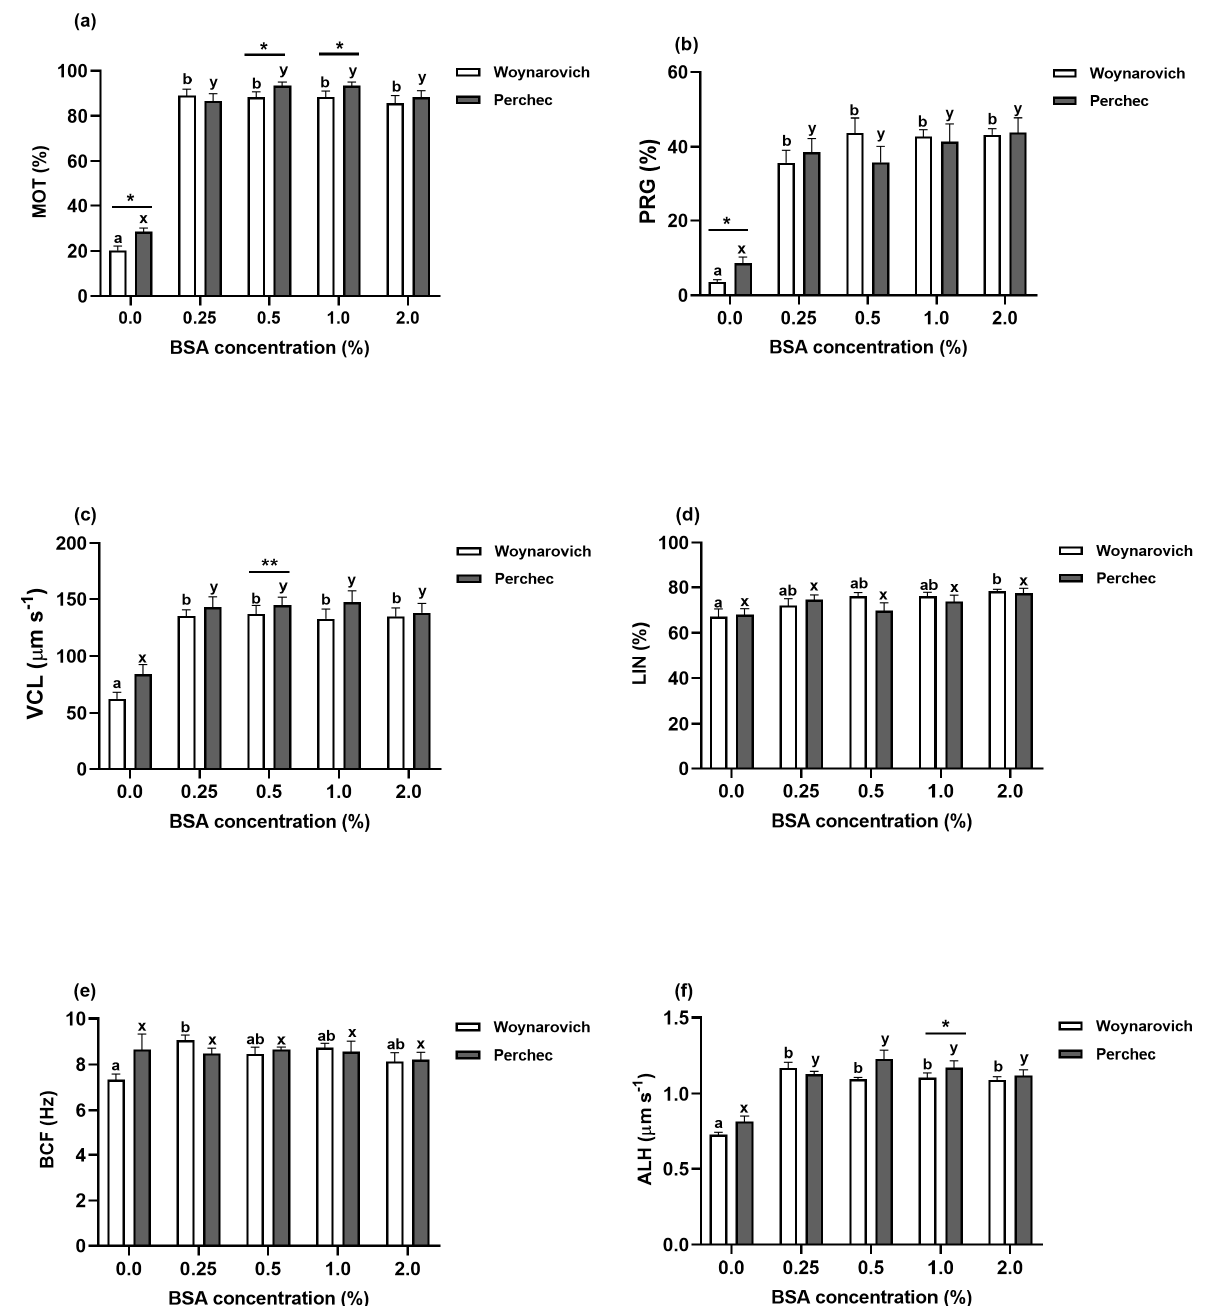
Figure 2. Percentages of motile sperm ( a ), progressively motile sperm ( b ), the curvilinear velocity of sperm ( c ), movement linearity ( d ), beat cross frequency ( e ), and amplitude of lateral head displacement ( f ) after activating ide ( Leuciscus idus , n = 5) sperm motility with Woynarovich and Perchec solutions containing different BSA concentrations. Results presented as mean ± SEM ( p < 0.05). Boxes marked with different letters ( a , b ) indicate significant differences among Woynarovich solutions supplemented with different BSA concentrations, and boxes marked with different letters (x,y) indicate significant differences among Perchec solutions supplemented with different BSA con- centrations. Asterisks indicate the level of statistical significance of values measured in Woyna- rovich and Perchec solutions at the same protein concentrations (* p < 0.05; ** p < 0.01).